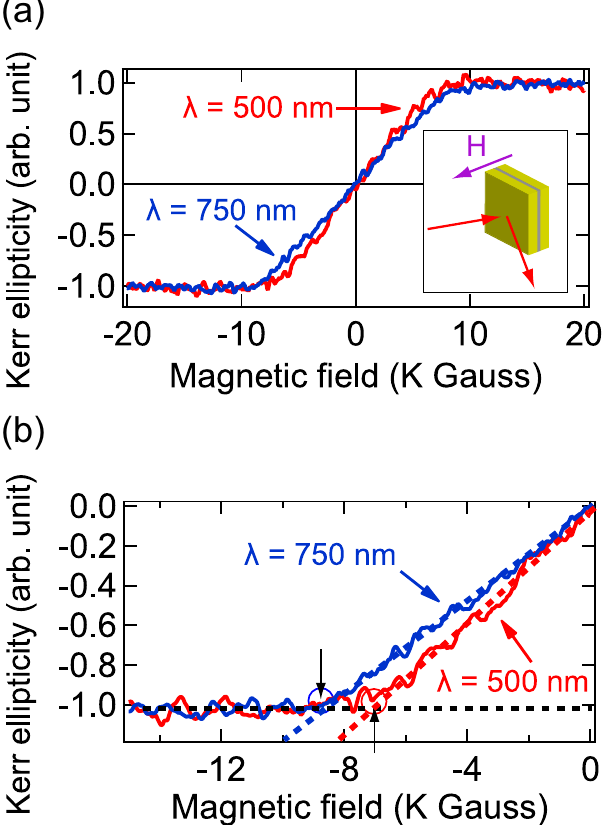
Figure 3. ( a ) Magnetic field dependence of normalized Kerr ellipticity in polar configuration (P-MOKE curve) for Au/Co/Au nanostructure at two different incident wavelengths ( λ ): 500 nm (red line) and 750 nm (blue line). The insert is schematic of polar magneto-optical Kerr effect (P-MOKE) measurement configuration. Magnetic field (H) is applied perpendicular to the surface of the Au/Co/Au nanostructure. ( b ) P-MOKE curves of Au/Co/ Au nanostructure at the negative magnetic field region. Red dashed lines is the fitted data for 500 nm and blue dashed lines is for 750 nm. Black dashed line is the saturation of Kerr ellipticity. The intersection of the black dashed line and the red or the blue dashed lines gives the saturation magnetic field. Black arrows indicate the saturation magnetic fields for λ = 500 nm (red circle) and 750 nm (blue